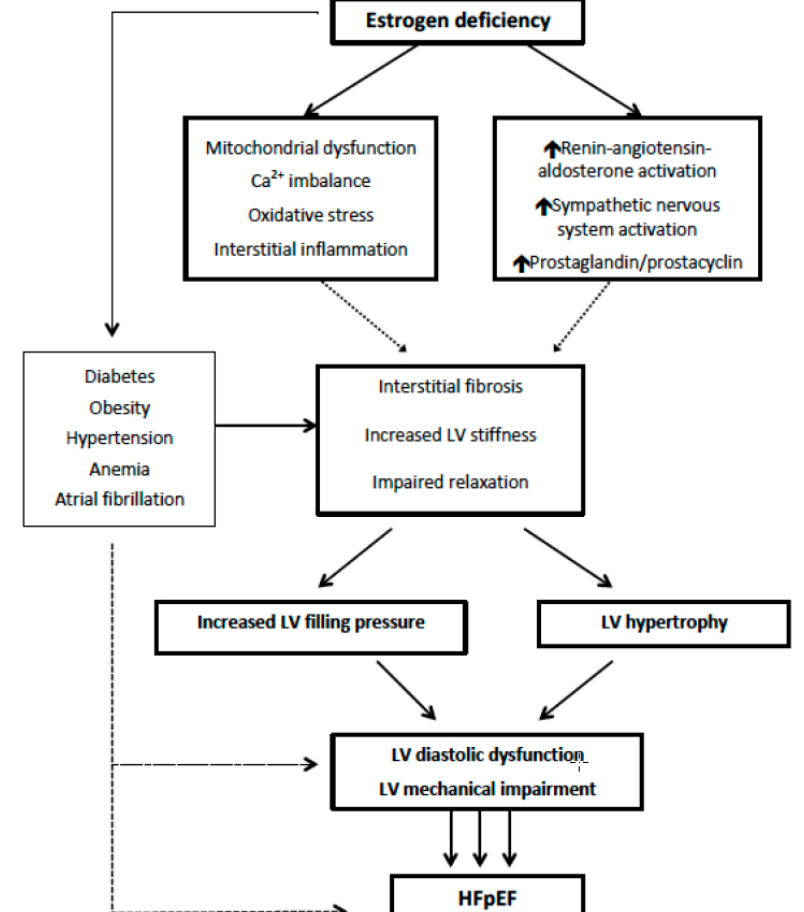
ff ect of estrogen deficiency in the pathophysiology of Figure 2. The effect of estrogen deficiency in the pathophysiology of HFpEF. Figure 2. The e Figure 2. The effect of estrogen deficiency in the pathophysiology of HFpEF.